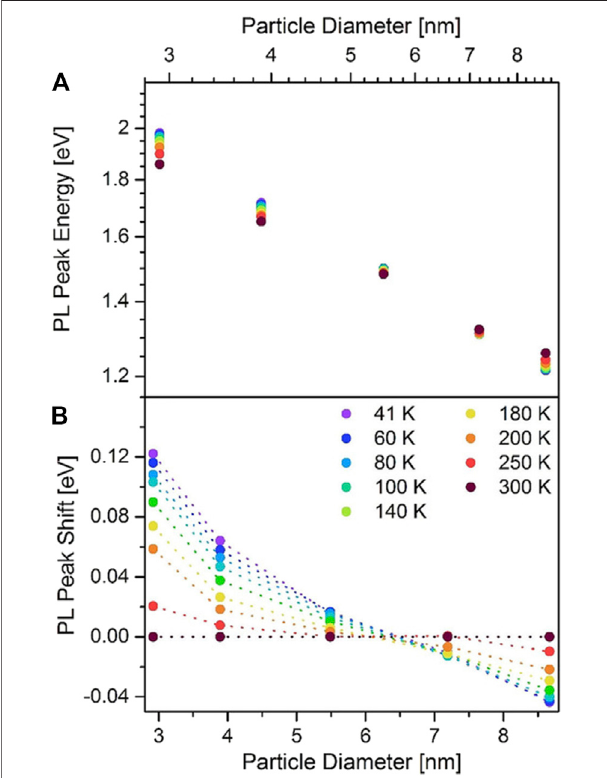
FIGURE6|(A) PLpeakenergyand (B) PLpeak shiftrelativetothepeak energy at 300 K versus SiNCs ’ size at selected temperatures reprinted with permissionfromJakobetal.(2019).Copyright2019Wiley-VCHVerlagGmbH & Co. KGaA, Weinheim.